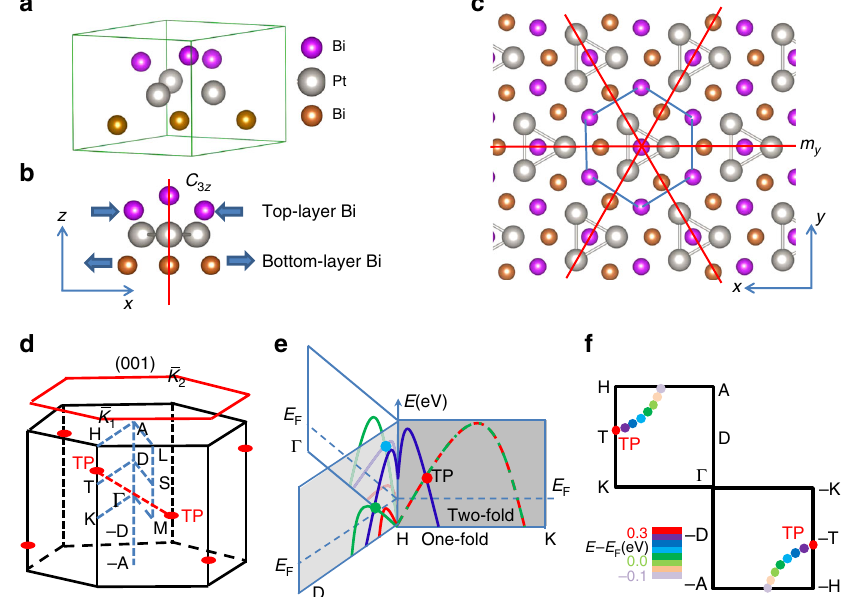
Fig. 1 Crystal structure and schematic electronic structure. a Three-dimensional crystal structure of trigonal layered PtBi 2 . Top and bottom layers of Bi are labeled with different colors. b Side view of the lattice showing C 3 z rotation symmetry. Shrinking of top Bi layer and extension of bottom Bi layer result in a lack of an inverse center of trigonal layered PtBi 2 . c Top view of lattice showing m y mirror symmetry; other two mirror re fl ection symmetries are obtained by rotating the top Bi atom. d Three-dimensional bulk Brillouin zone (BZ) and (001) surface BZ with high-symmetry points are indicated. Red spots indicate TPs. Red-dashed line connects a pair of TPs. e Schematic band structures along three different high-symmetry lines. Red spots at the crossing points along line H – K indicate the TPs. The light blue and green spots along H – Г and H – D are doubly degenerate points. Curves of mixed red and green color represent doubly degenerate bands (twofold) and those of single color represent nondegenerate bands (onefold). f Tracks of degenerate point around the Fermi level in H – K – Γ – A plane. Colors of the spots represent the energy relative to the Fermi energy E F . The point at line H – K is a TP, and the points off the H – K line